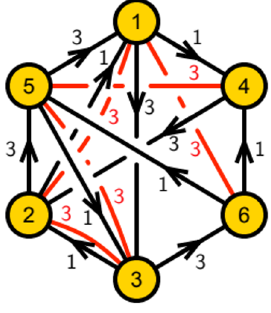
Figure 18 . Quiver for Model